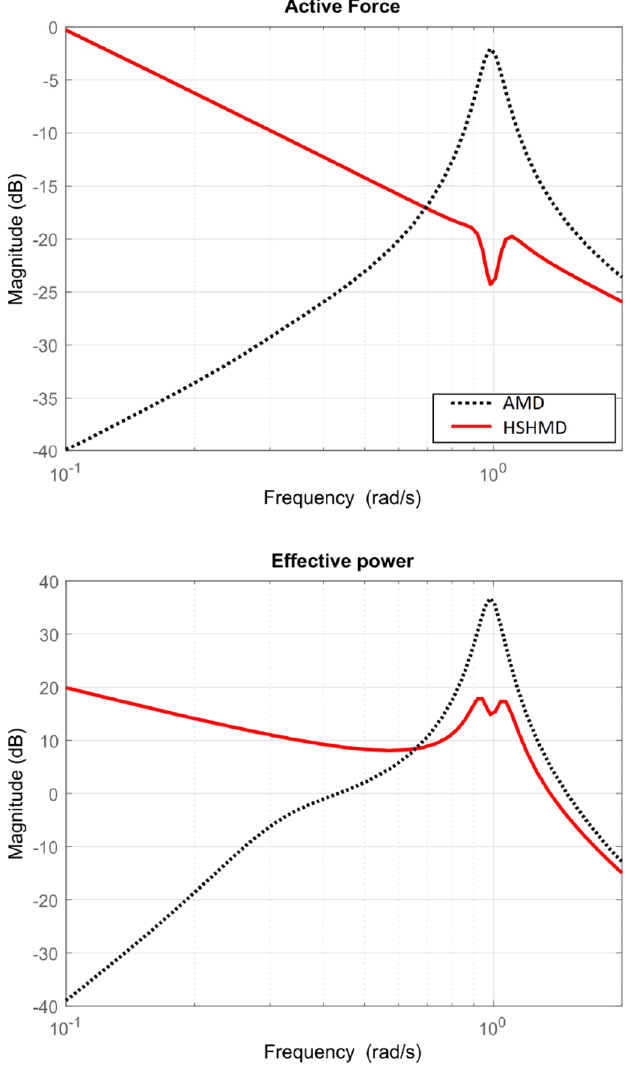
Fig. 8. Comparison of active force and global power consump- tion (Black dotted line: AMD. Red line: